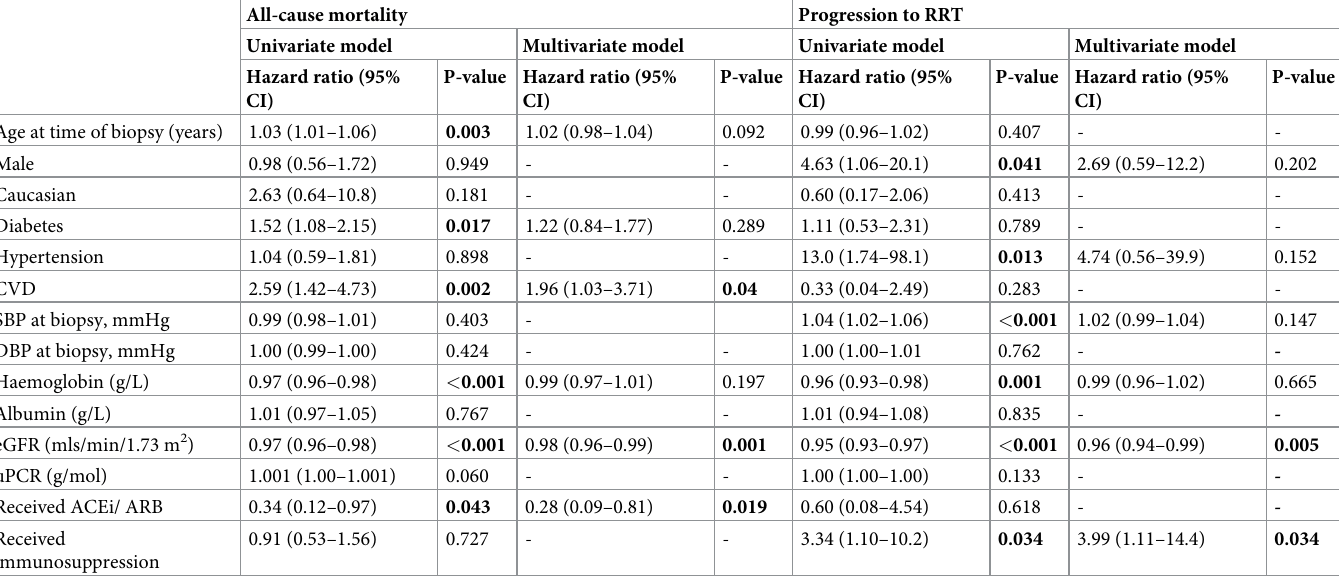
Table 2. Association between baseline variables and all-cause mortality and progression to